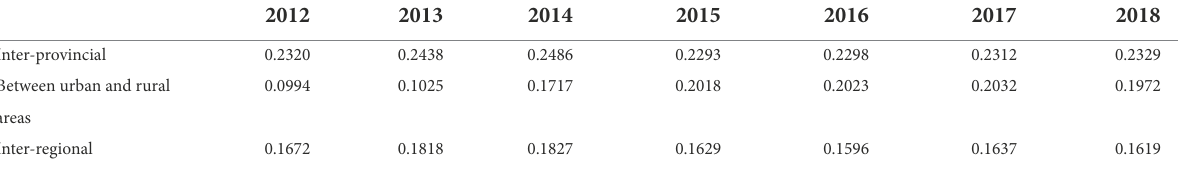
TABLE 3 Gini coefficient for intergroup funding for kindergarten education.